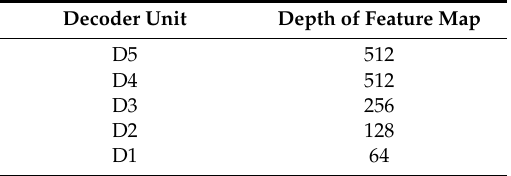
Table 2. Depth of feature map generated by each decoder